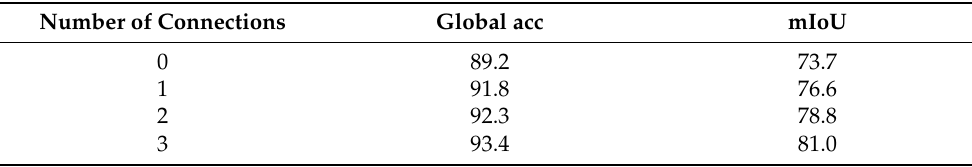
Table 2. The results in the experiment of the number of connections.